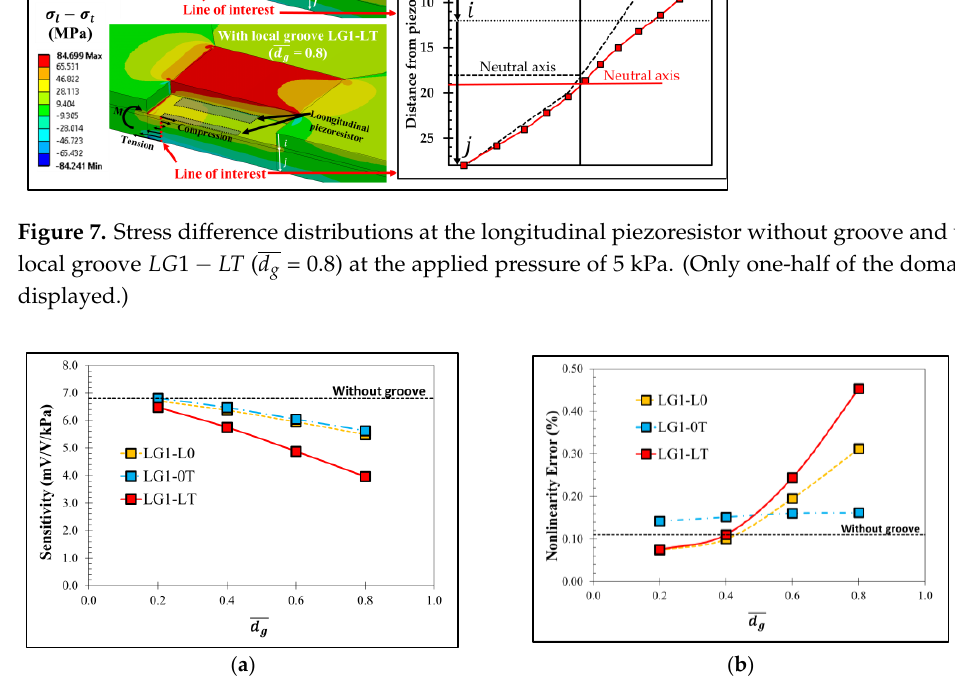
Figure 8. Variations of ( a ) sensitivity and ( b ) nonlinearity error with dimensionless groove depth of sensor with local grove 𝐿𝐺1 .